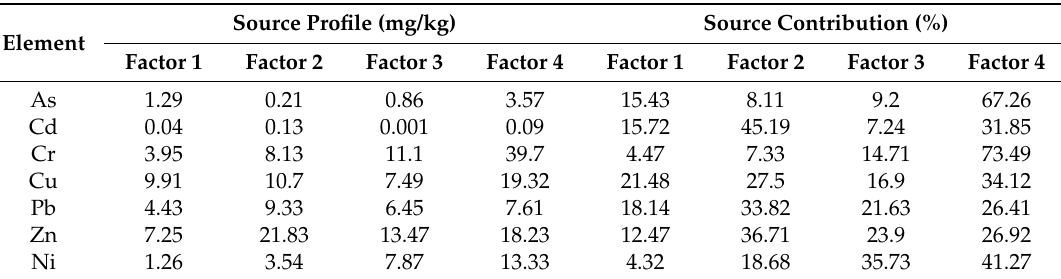
Table 7. Source contribution for different elements by